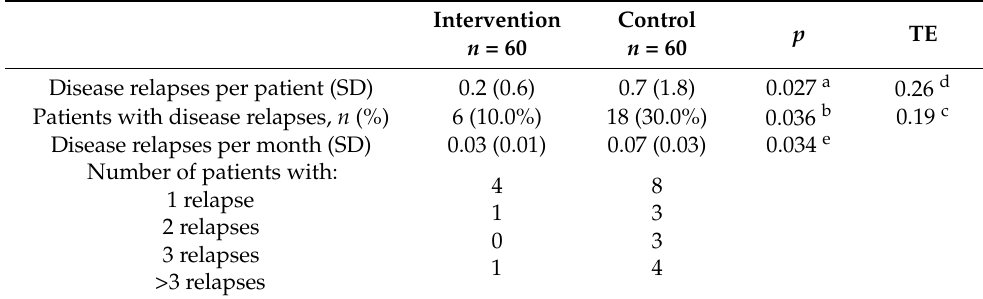
Table 4. Effectiveness of the group psychological intervention program in activity measured by mean number of flares, number of patients with flares post-treatment, mean number of flares per month and number of flares in intervention and control arms. Intervention Control n = 60 n = 60